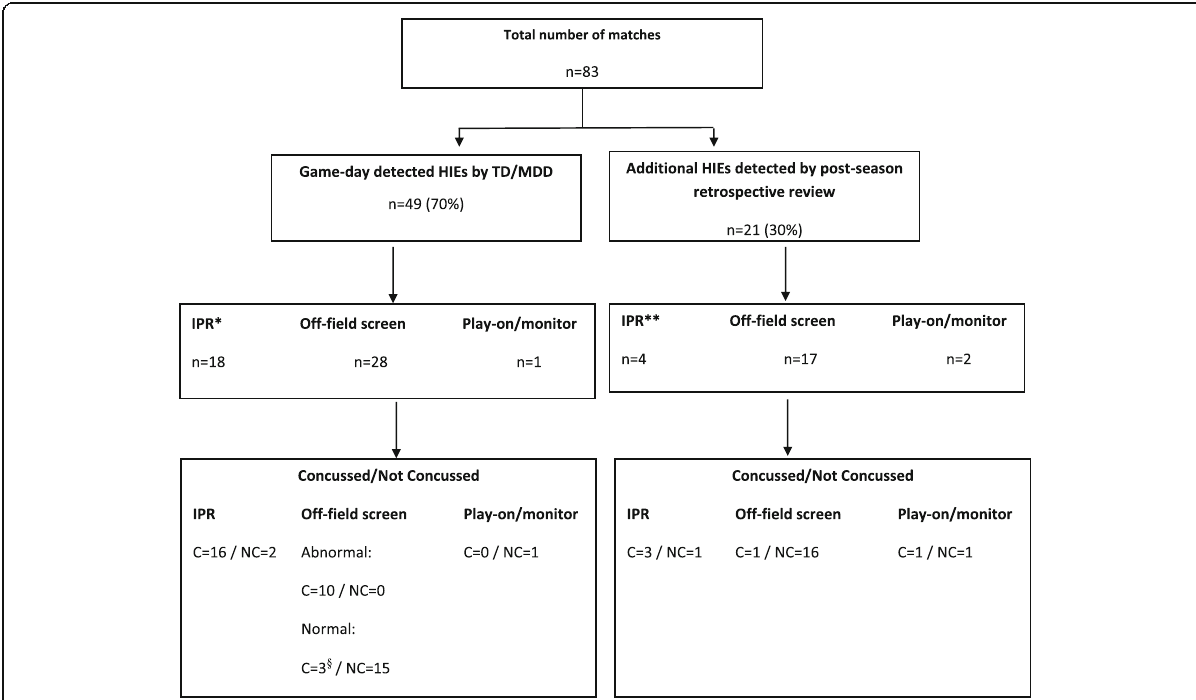
Fig. 1 Summary of identified HIEs and diagnosed concussions.*TD/MDD decision; **independent evaluation decision; § players returned to play but were subsequently (post-match) diagnosed with concussion; IPR immediate and permanent removal